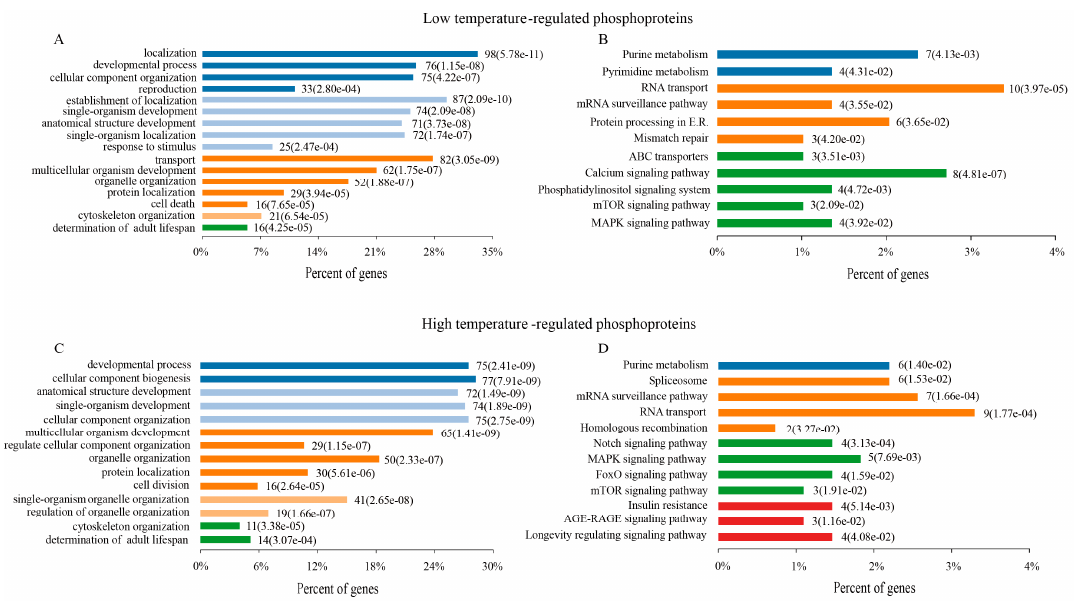
Figure 2. The determination of differentially regulated phosphoproteins (DRPs). Volcano plot analysis of DRPs in C. elegans exposed to 15 °C (A) or 25 °C (B). Heatmap of DRPs in C. elegans at 15 °C (C) or 25 °C (D). Subcellular localization of the phosphoproteins at 15 °C (E) or 25 °C (F).